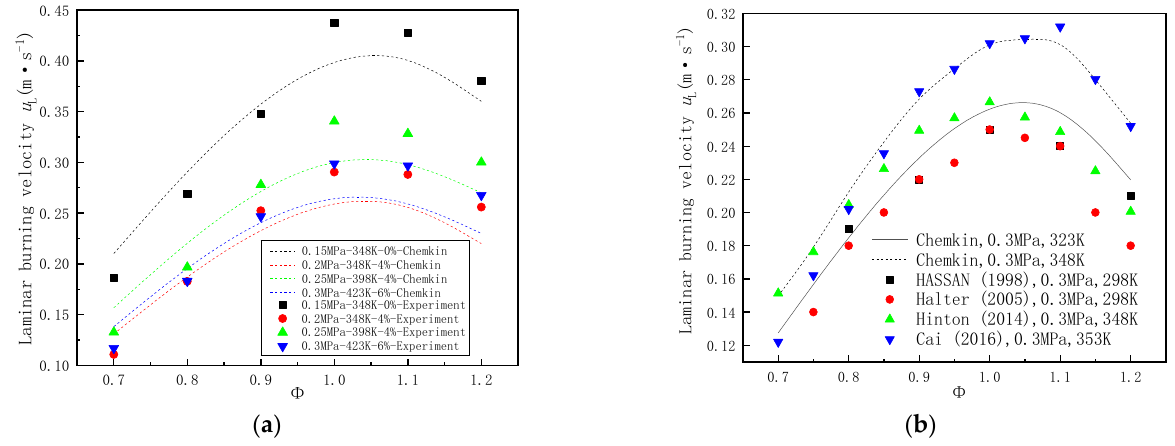
Figure 3. Validation of present simulation studies: ( a ) compared with experimental data and ( b ) compared with previous data.